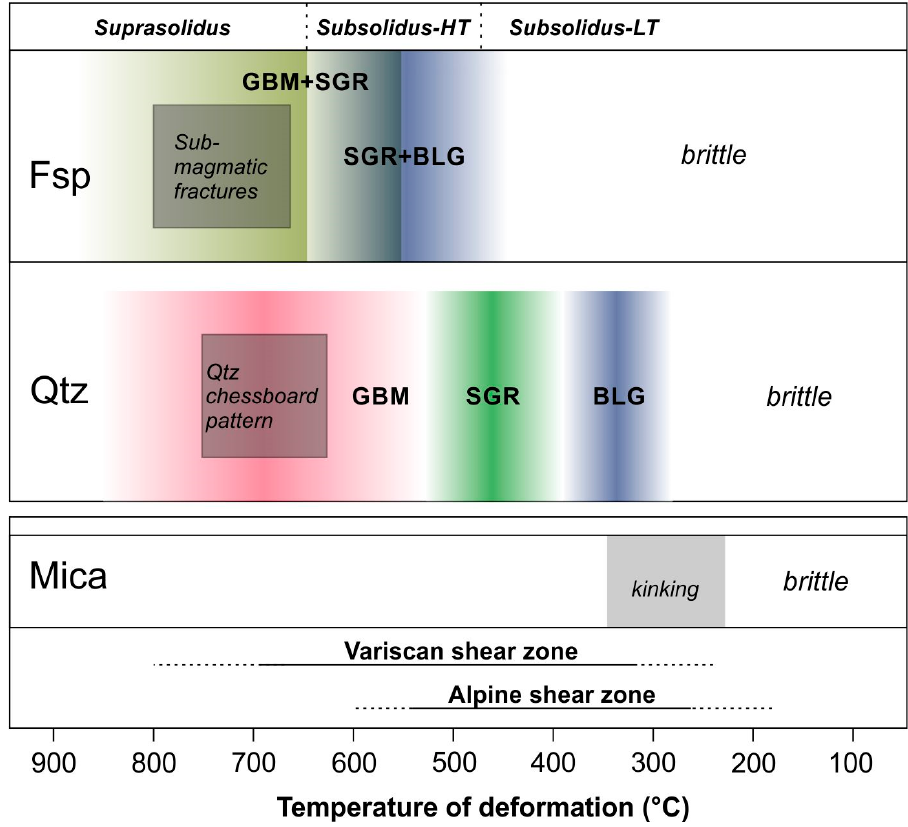
Figure 9. Submagmatic to solid state thermal ranges of deformation mechanisms and associated microstructures for various minerals (feldspar, quartz, and mica) recognized in the studied granitoid rocks (temperature range estimates after [95,96,98,138–141]. BLG = bulging recrystallization; SGR = subgrain rotation recrystallization; GBM = grain boundary migration recrystallization. Thermal conditions for Variscan syntectonic granitoids and Alpine shear zones in the Calabria-Peloritani Orogen are also shown (after [51] and references therein).